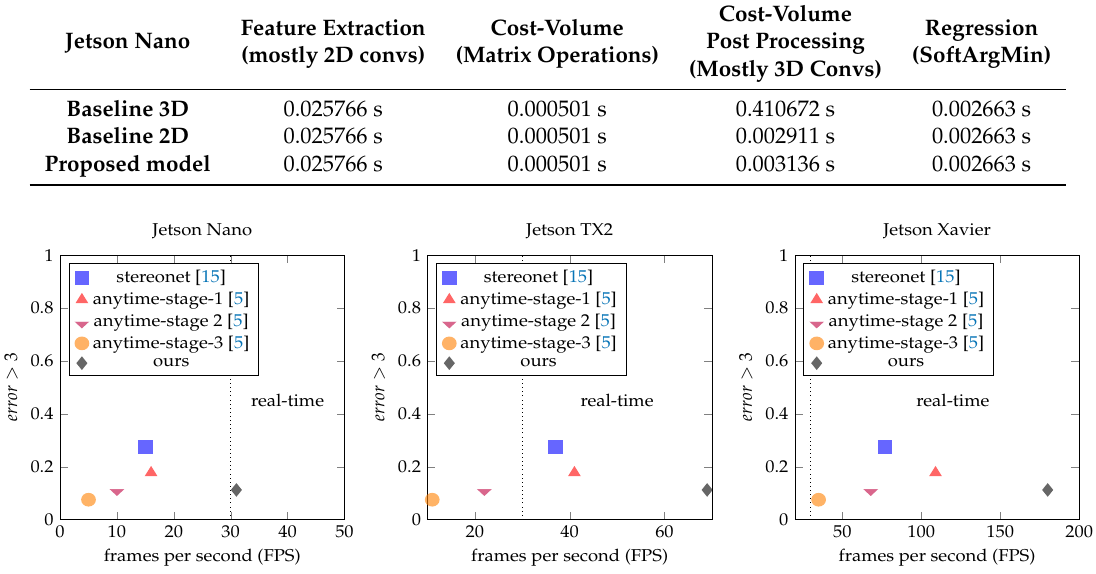
Figure 3. Comparative results of our method against state-of-the-art models. All models are optimized as in Section